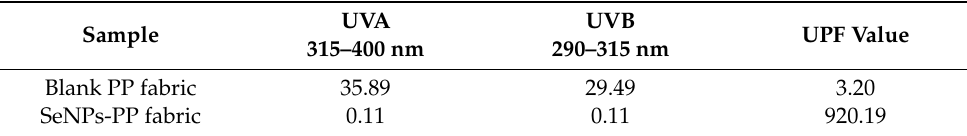
Table 4. UPF of the PP and SeNPs-PP